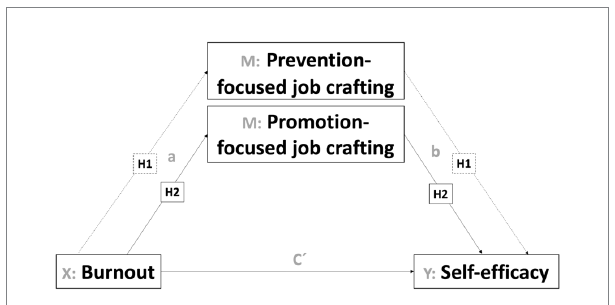
FIGURE 2 Mediation model of job crafting’s dimensions in the influence of burnout on self-efficacy.